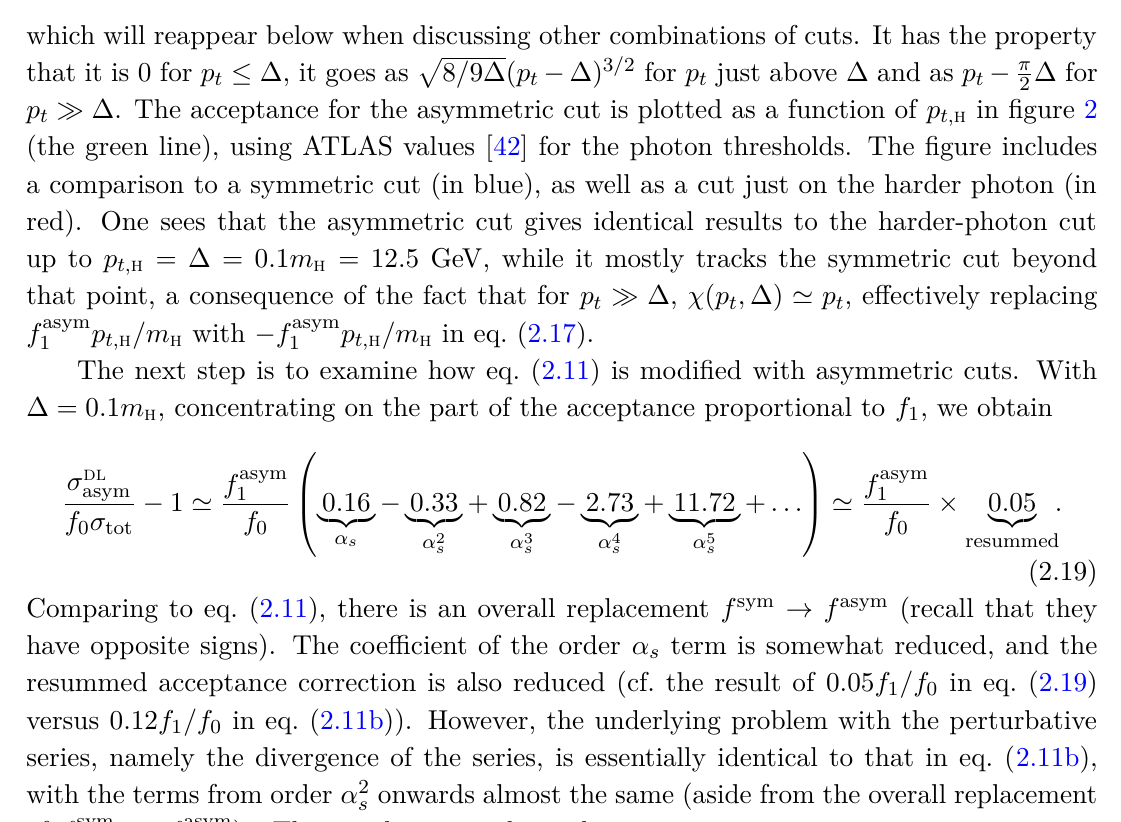
Figure 2 . Acceptance for Higgs to di-photon decays, f ( p t, h ) , as a function of p t, h , for a symmetric cut on the photons ( p t, − , p t, + > 0 . 25 m h ), a cut just on the harder photon ( p t, + > 0 . 35 m h ) and an asymmetric cut, where both conditions are imposed. Points are Monte Carlo evaluations of the ac- ceptance (whose value is independent of any perturbative order), while the lines use eqs. (2.7), (2.14) and (2.17), extended to fourth order in p t, h /m h . Where a band is visible, its width corresponds to the difference between third and fourth order